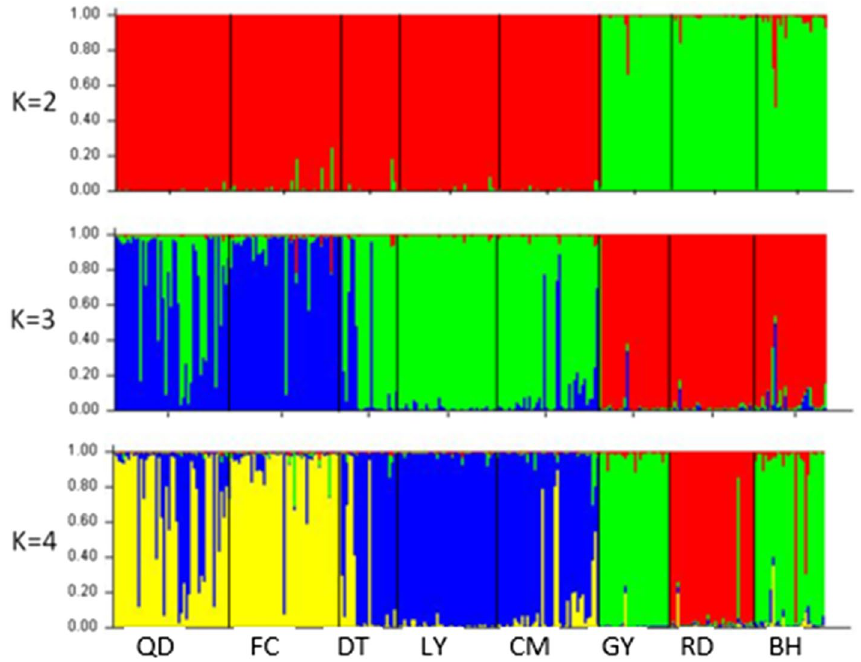
Figure 2. STRU CTU RE genetic cluster analysis for L. maculatus populations. LY Lieyu, CM Chongming, DT Dongtou, QD Qingdao, FC Fangcheng, GY Ganyu, RD Rudong, BH Binhai. The population names were given below the box plot with the individuals of different populations separated by vertical black lines. Each color represents “one